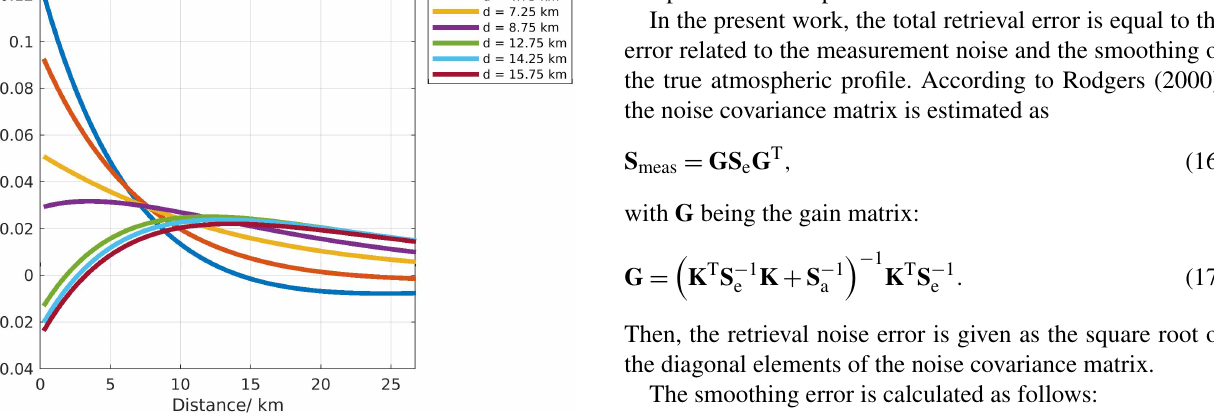
Figure 15. Example of NO 2 averaging kernels. They are calculated for observations on 11 September 2018 at 11:51UTC and 300 ◦ az- imuthal